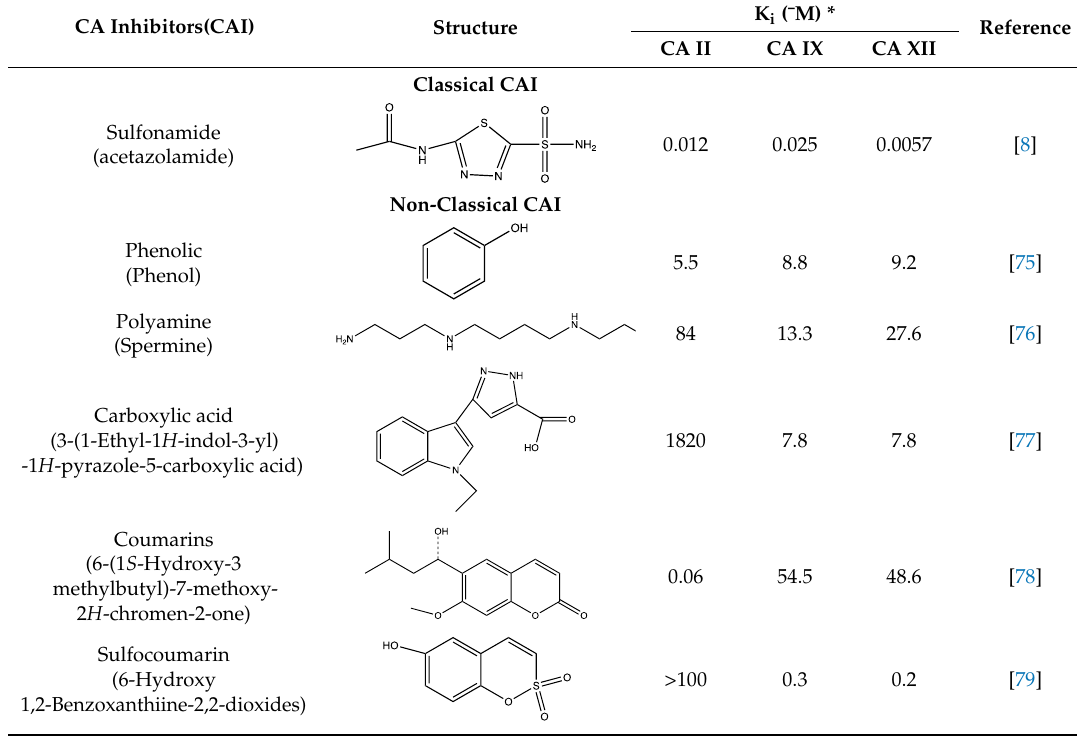
Table 1. Structures and binding constants of CA inhibitors in CA II, CA IX and CA XII.